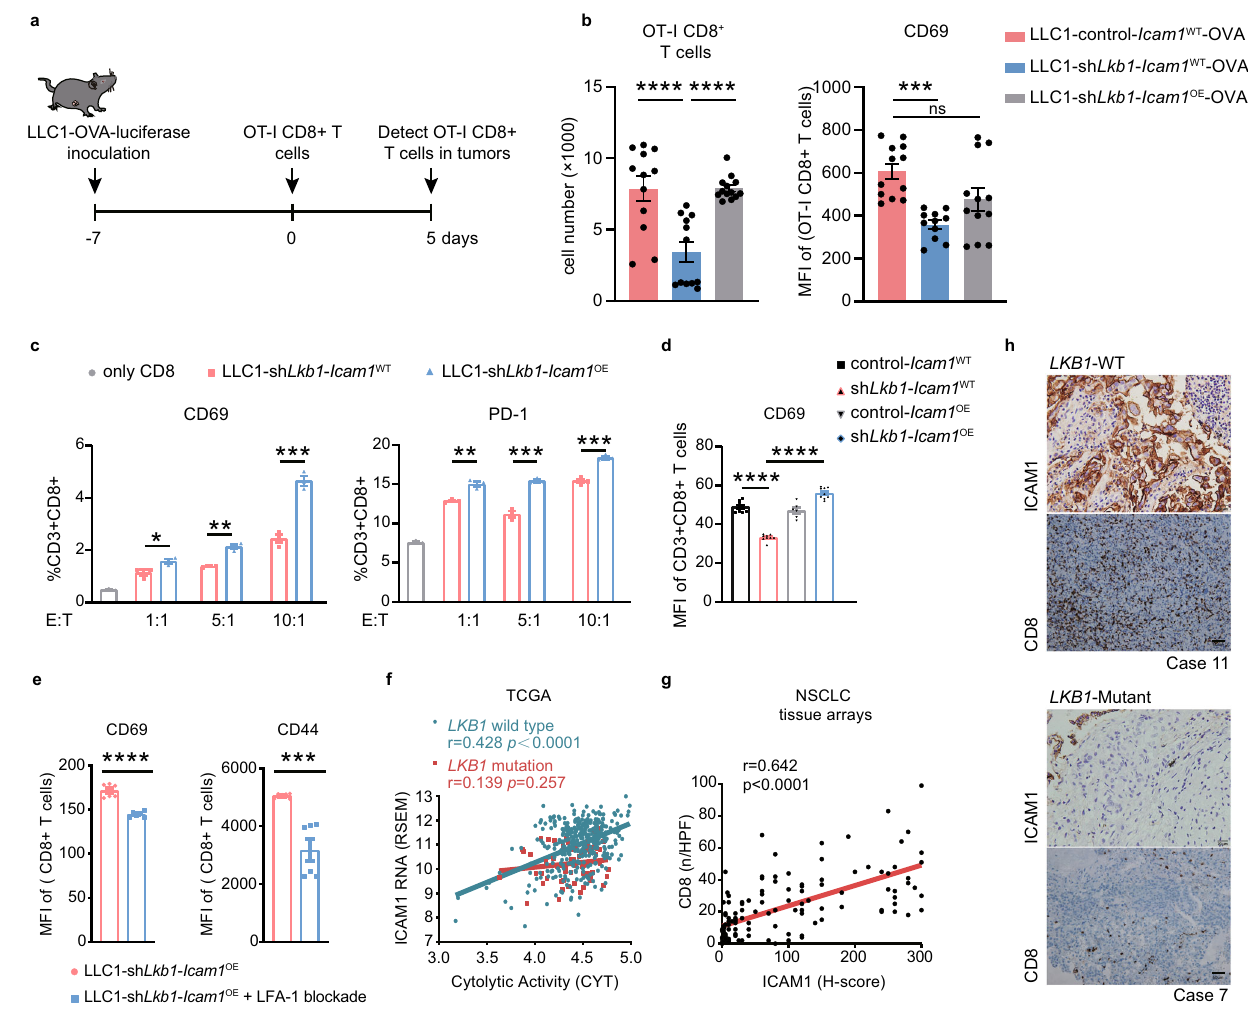
Fig. 3 | ICAM1 is important for the homing and activation of tumor-speci fi c T cells in LKB1 de fi cient lung cancer. a LLC1-OVA tumor cells (LLC1-control- Icam1 WT -OVA; LLC1-sh Lkb1 - Icam1 WT -OVA; LLC1-sh Lkb1 - Icam1 OE -OVA) were implan- ted. Congenitally-marked (APC + ) and stimulated CD8 + T cells expressing the OT-I weretransferredonday7andanalyzedonday12. b In fi ltrationofOT-ICD8 + Tcells (left)andexpressionofCD69onOT-Icells(right)wereanalyzedby fl owcytometry. For CD8 + T cells, n =12, n =12 and n =13 in control- Icam1 WT , sh Lkb1 - Icam1 WT and sh Lkb1 - Icam1 OE groups, respectively. **** p <0.0001, **** p <0.0001. For CD69, n =12, n =11 and n =12 in control- Icam1 WT , sh Lkb1 - Icam1 WT and sh Lkb1 - Icam1 OE groups, respectively. *** p =0.0003. c Flow cytometry analysis of CD69 and PD-1 expression on activated T cells with or without co-culturing with LLC1 tumor cells (sh Lkb1 - Icam1 WT , sh Lkb1 - Icam1 OE ) for 24h. The E : T ratio (effector to target) was 1:1, 5:1, and 10:1 respectively. n =3 biologically independent samples examined over 1 independent experiment. CD69, * p =0.038, ** p =0.0012, *** p =0.0009; PD-1, ** p =0.0036, *** p =0.0007, *** p =0.0009. d Flow cytometry analysis of CD69 expressiononactivatedTcellsco-culturingwithLLC1tumorcells(control- Icam1 WT , n =9; sh Lkb1 - Icam1 WT , n =9; control- Icam1 OE , n =6; sh Lkb1 - Icam1 OE , n =9) for